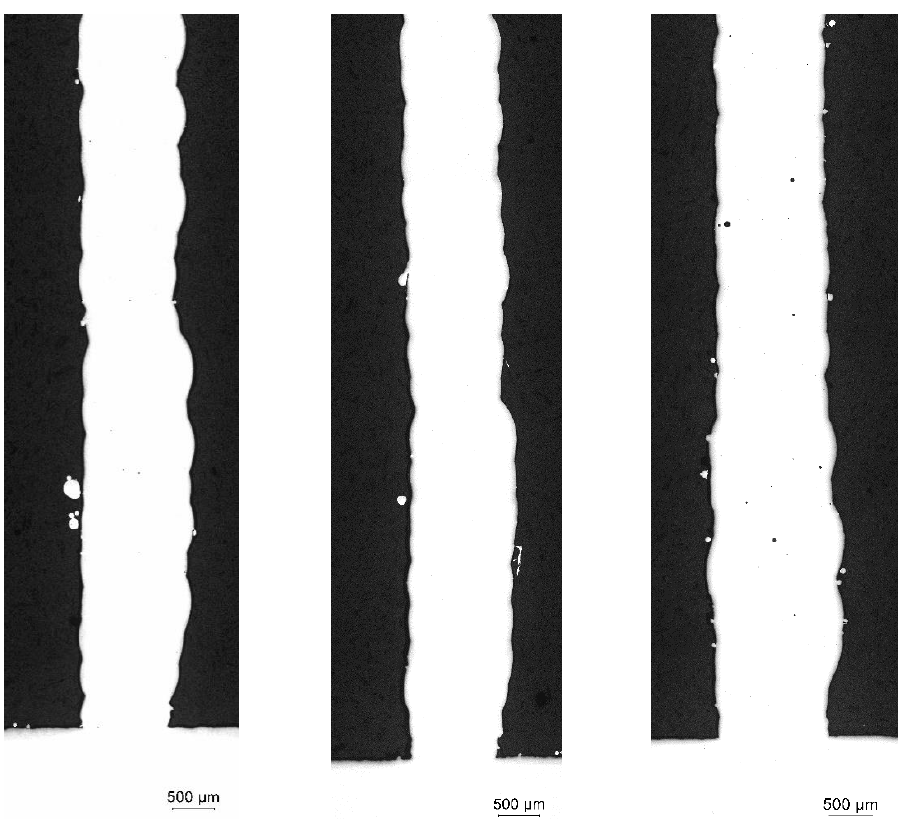
Figure 11. Photomicrograph of walls in a polished state. SS316L walls of sample 1 ( left ), sample 2 ( center ) and sample 3 wall manufactured with IN718 ( right ).